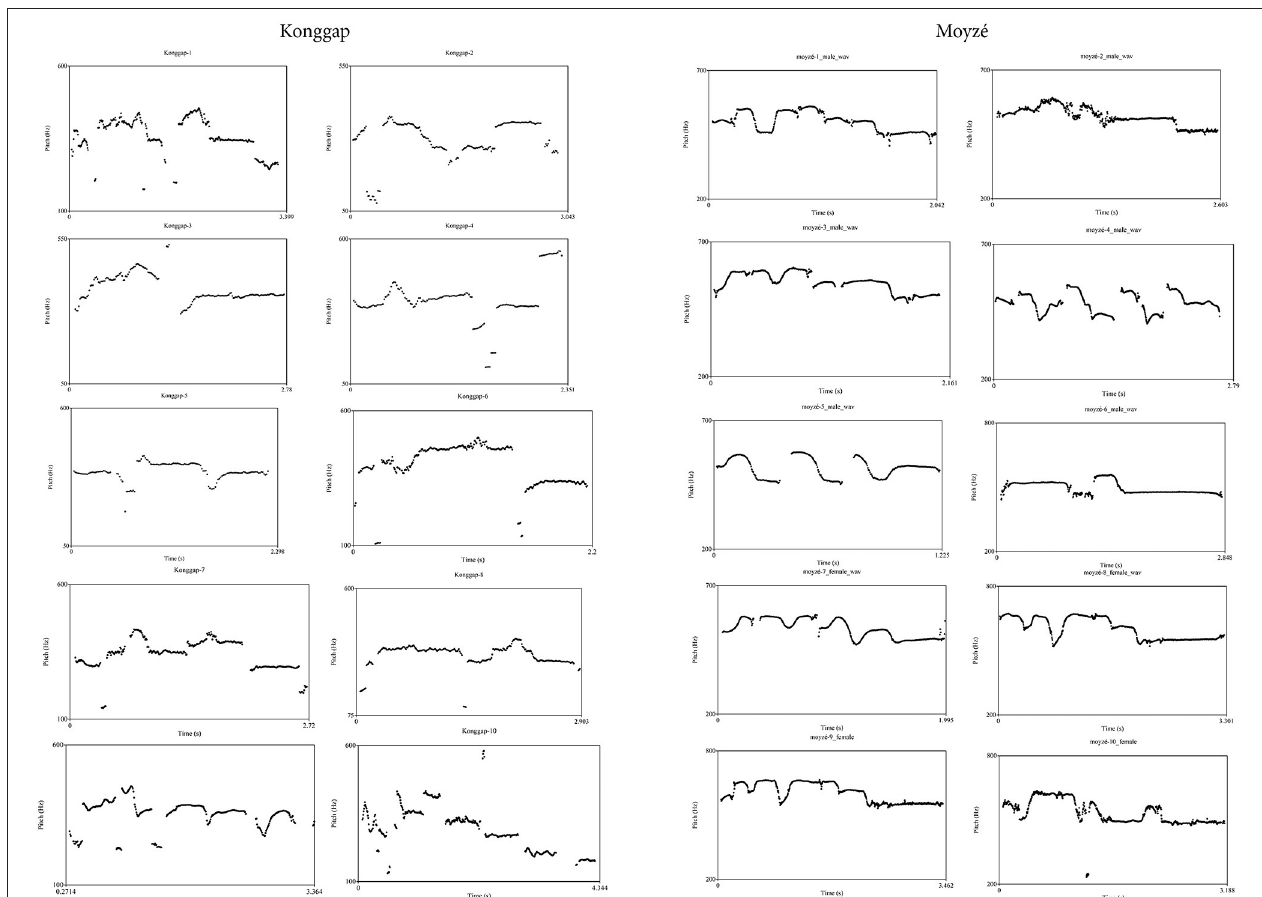
FIGURE 1 | Pitch traces for 10 sung konggap and 10 whistled moyzé name